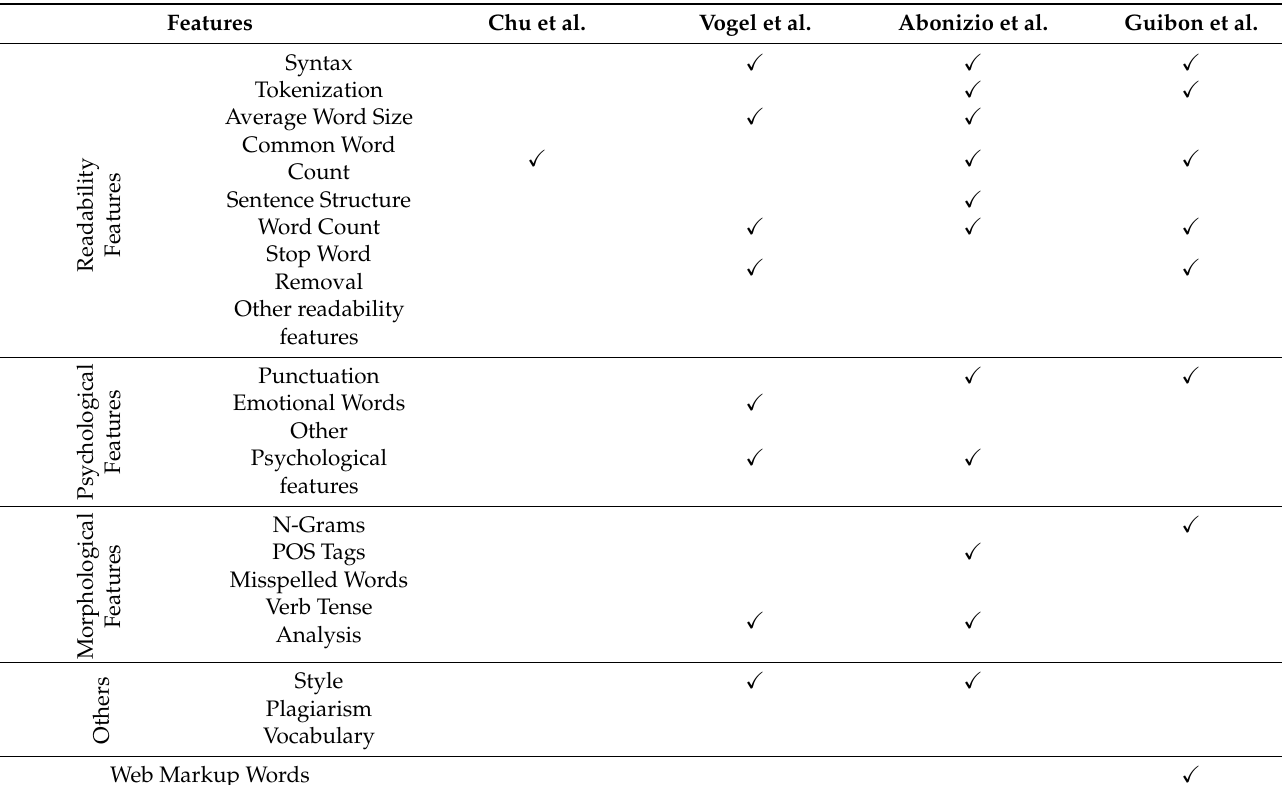
Table 9. Data Pre-Processing Features Used in Cross-Language Methodologies.